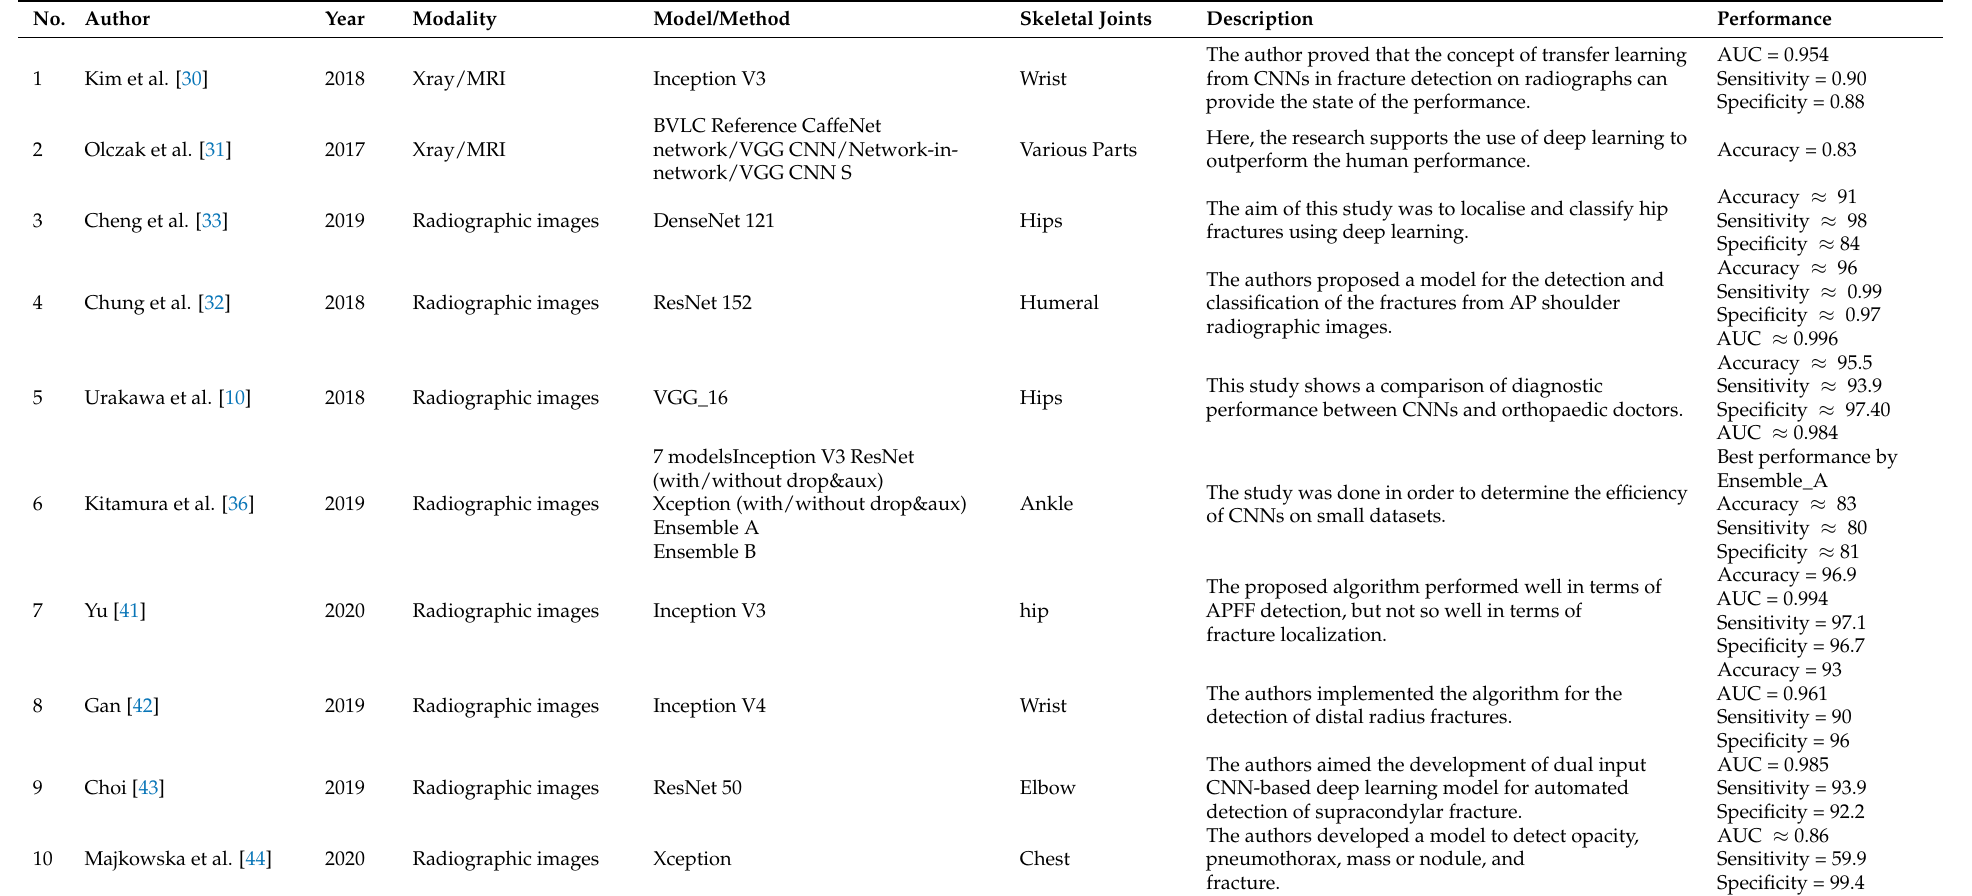
Table 1. Performance of various models for fracture